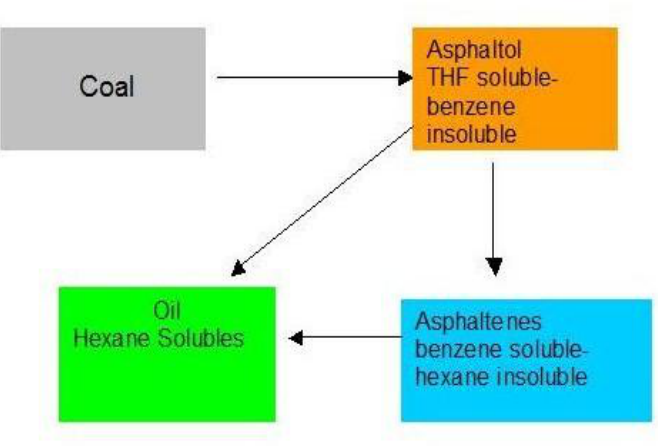
Figure 1. Coal liquefaction